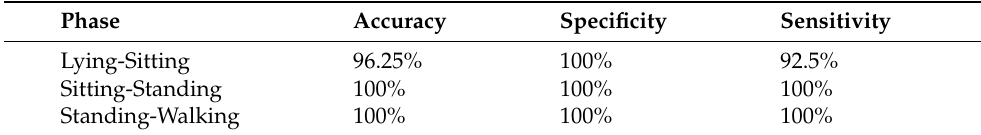
Table 7. Results of movements test with